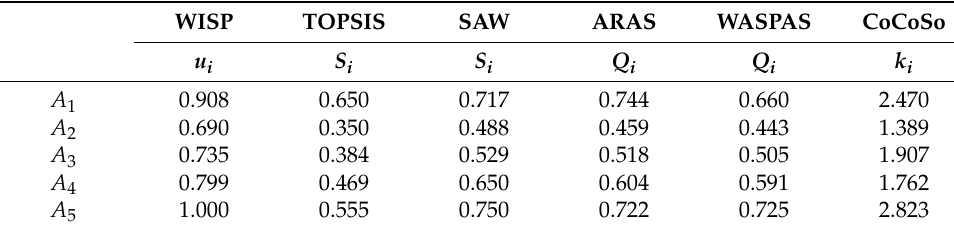
Table 2. The utility of alternatives obtained based on the first decision-making matrix. WISP TOPSIS SAW